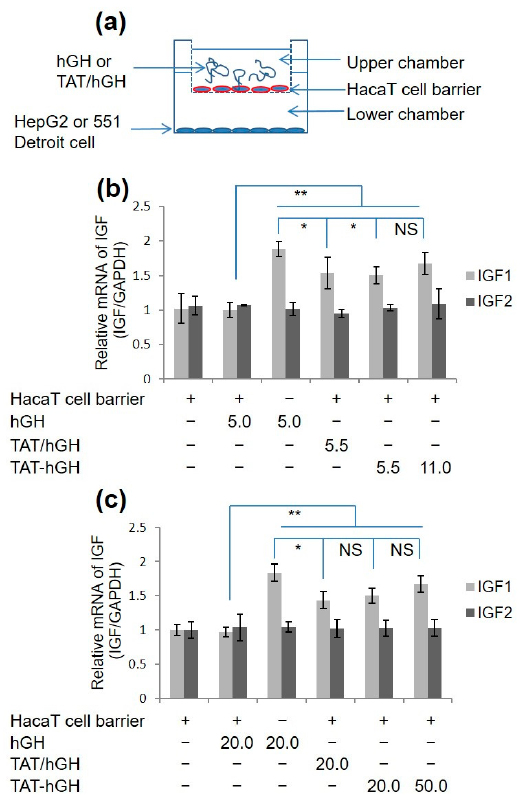
Figure 3. IGF mRNA expression in fibroblast cell lines treated with hGH, a mixture of TAT and hGH (TAT/hGH), and TAT-hGH. ( a ) Schematic illustration of the cell membrane permeability model using a trans-well system. ( b ) IGF mRNA expression in the HepG2 cell line. ( c ) IGF mRNA expression in the 551 Detroit cell line. Values are presented as the mean ± standard deviation ( n = 3). NS indicates no significance; * indicates p < 0.05 vs. the control (vehicle); ** indicates p < 0.01 vs. the control